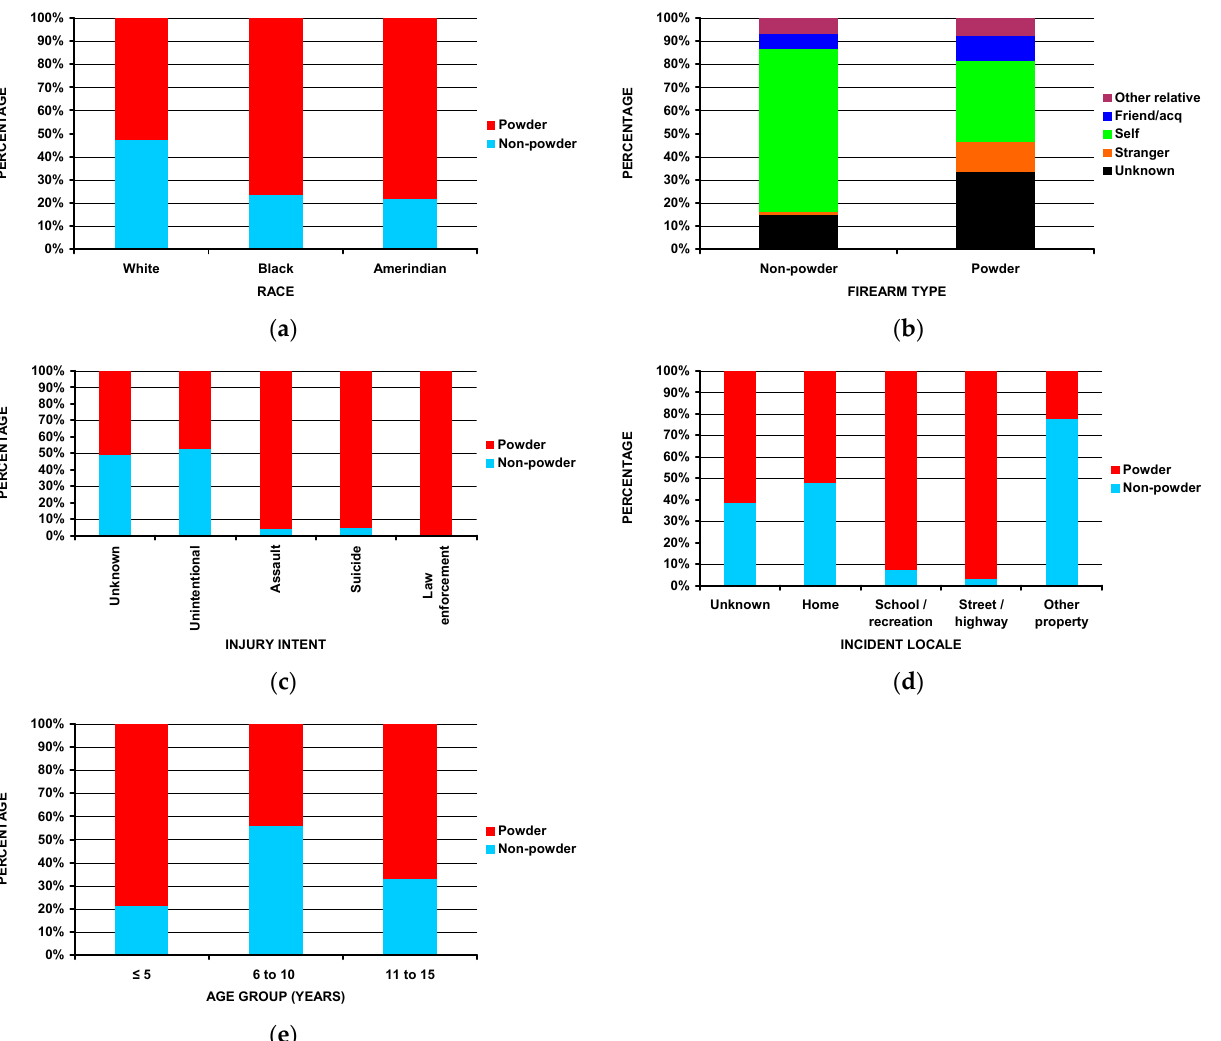
Figure 3. Differences between powder and non-powder firearms: ( a ) by race ( p = 0.0005); ( b ) by perpetrator of the injury ( p < 10 − 4 ); ( c ) by injury intent ( p < 10 − 4 ); ( d ) by incident locale ( p < 10 − 4 ); ( e ) by age group ( p = 0.006).